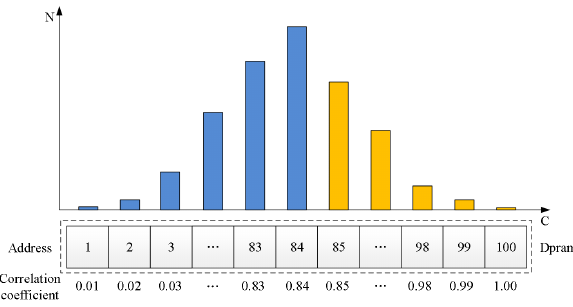
Figure 19. Dpram for histogram